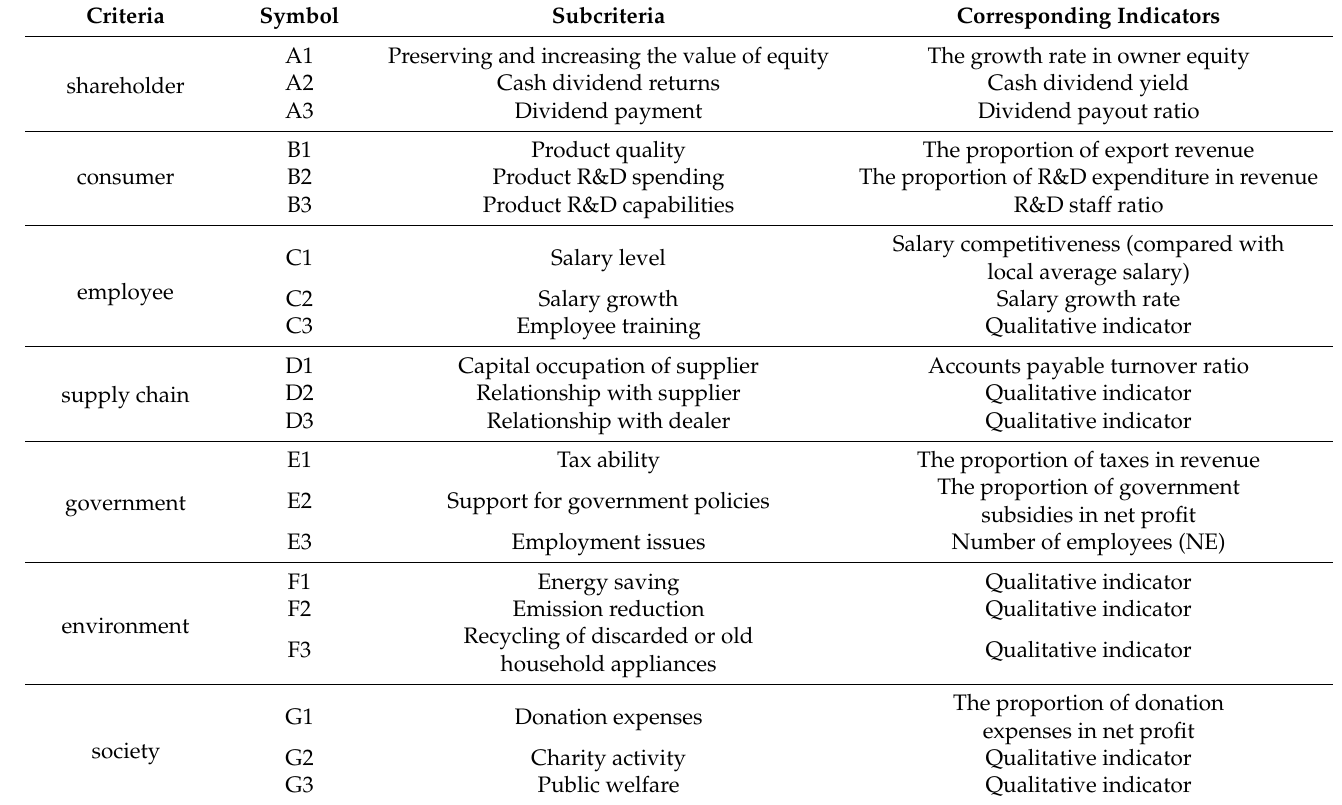
Table 1. Criteria, subcriteria and corresponding indicators constructed for assessing corporate social responsibility (CSR).